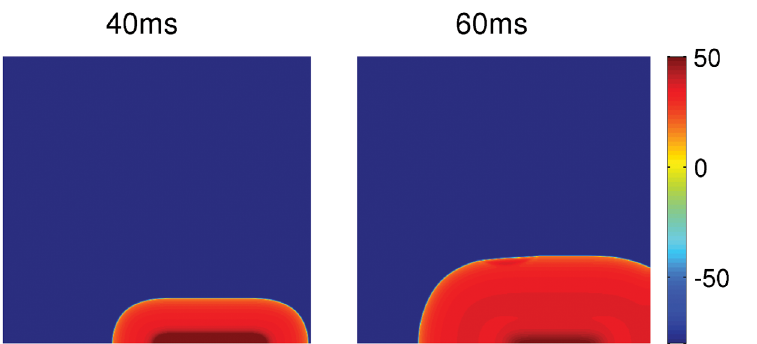
Fig 1. Asymmetric pacing protocol. Pseudocolor plots showing the spatiotemporal evolution of V m and depicting the pacing protocol we use for our 2D simulation. The stimulus is applied over a region of 0.14x3 cm 2 on the lower-right boundary of the domain. The colorbar indicates the value of V m in mV.